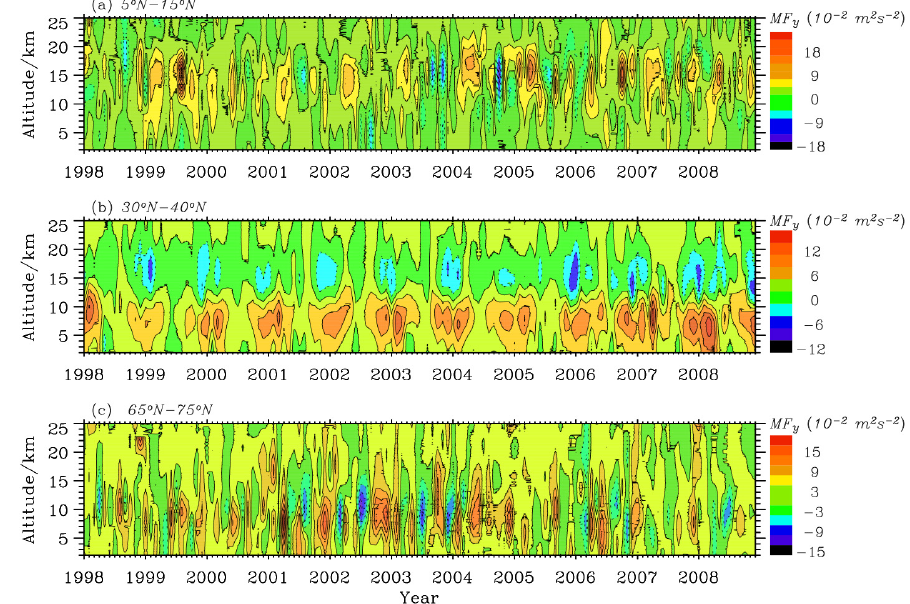
Figure 11. Monthly averaged meridional momentum fluxes (in 10 − 2 m 2 s − 2 ) at low (a) , middle (b) and high (c)